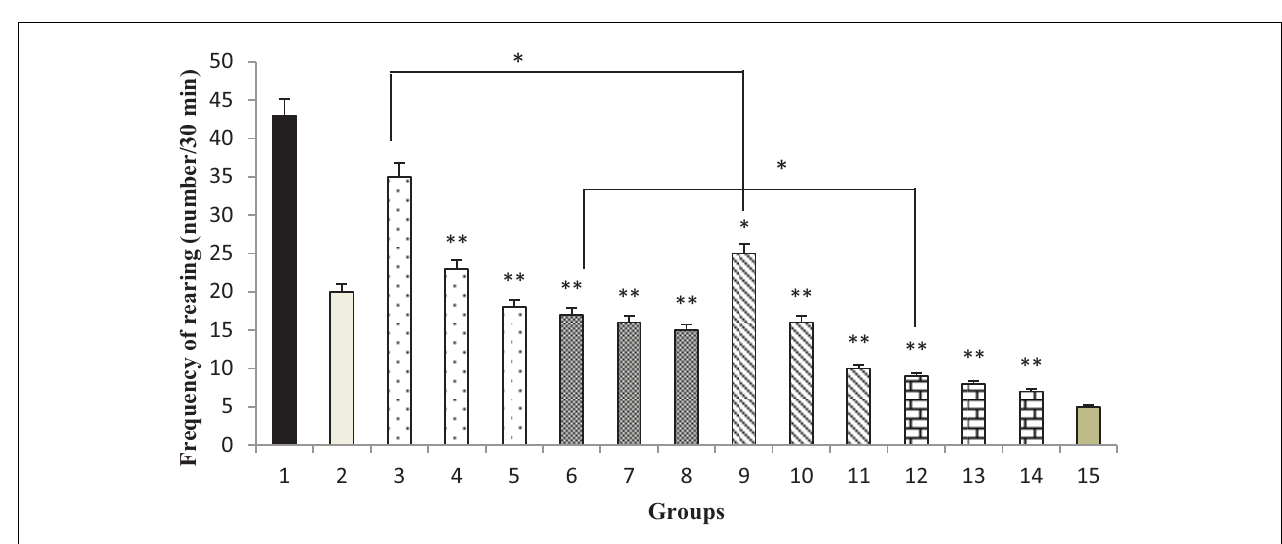
FIGURE 10 | The frequency (number of rearing/30 min) of rearing in rats. Group 1; morphine-dependent rats (control). Group 2; morphine-dependent rats and coadministration of clonidine hydrochloride (0.2 mg/kg i.p.) (positive control). Groups 3, 4, and 5; morphine-dependent rats and the coadministration of 100, 200, and 300 mg/kg Thymbra spicata extract, respectively. Groups 6, 7, and 8; morphine-dependent rats and coadministration of 30, 60, and 90 mg/kg thymol, respectively. Groups 9, 10, and 11; morphine-dependent rats and coadministration of 100, 200, and 300 mg/kg extract nanopolymer, respectively. Groups 12, 13, and 14; morphine-dependent rats and coadministration of 30, 60, and 90 mg/kg thymol nanopolymer, respectively. Group 15; non-dependent rats (saline). Data are expressed as mean ± SEM. ∗ P < 0.01 vs. control, ∗∗ P < 0.001 vs.